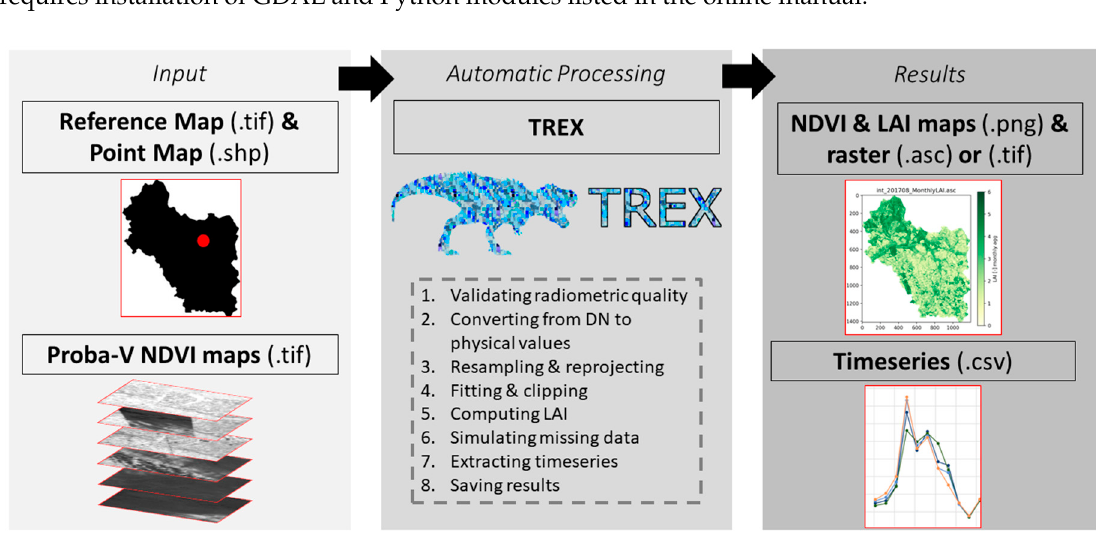
Figure 1. Generic scheme of TREX processing chain.